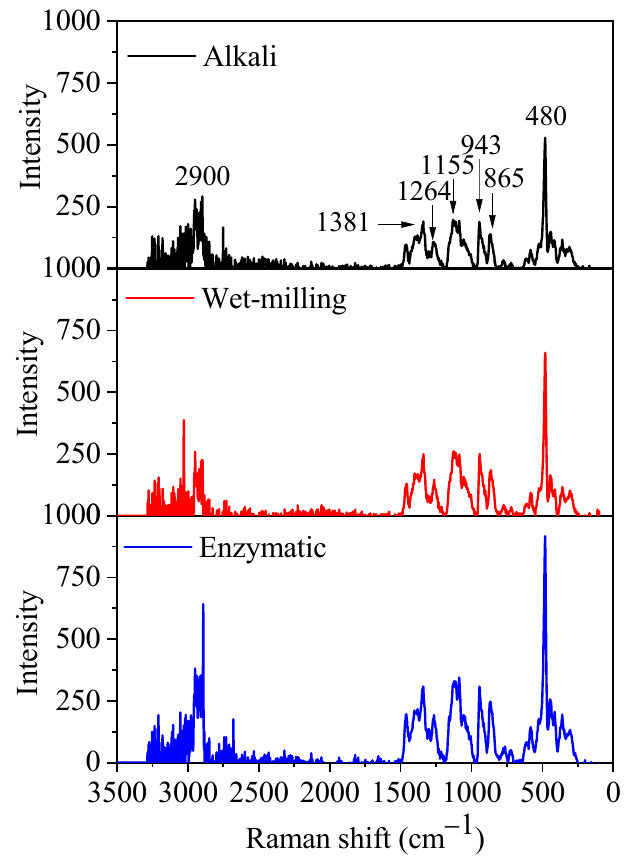
Figure 3. Raman spectrum of quinoa starch subjected to three different methods (alkali, wet-milling, and enzymatic).